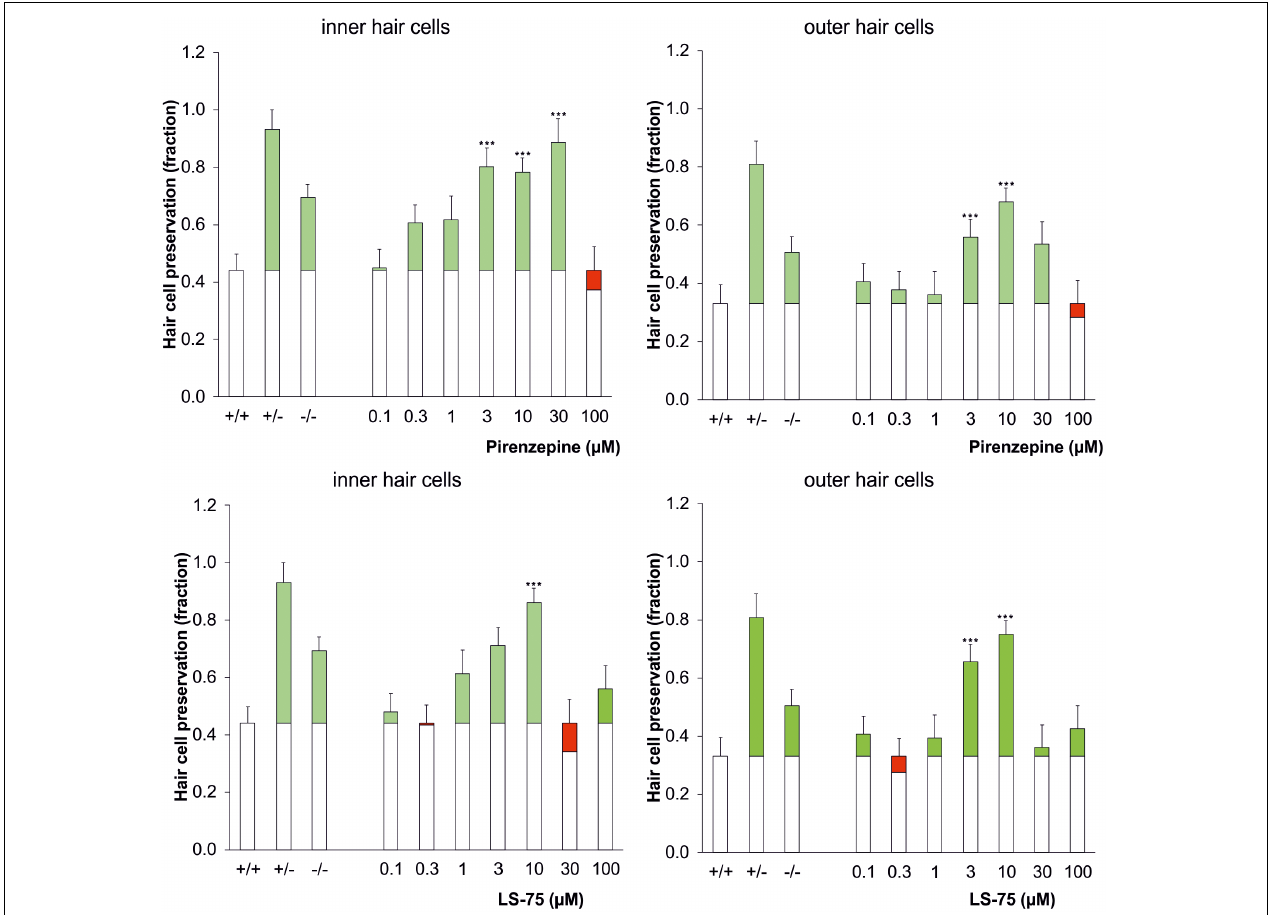
FIGURE 2 | Dose-response effect of the PARP inhibitor pirenzepine (top row) or LS-75 (bottom row) on the survival of inner (left) and outer hair cells (right) in the cisplatin ototoxicity model, mimicking the effect of the genetic ablation of PARP in a dose range of 3–10 µ M. As controls the genotypic results (cf. Figure 1 ) are plotted on the left columns. The white bars indicate the hair cell preservation rate of control cochleae, and the colored portions of the bars indicate the difference in the wildtype control (cisplatin treated) (green: preservation; red: loss). Differences to the wildtype control were calculated using Dunnetts test ( ∗∗∗ p < 0.001 values were considered